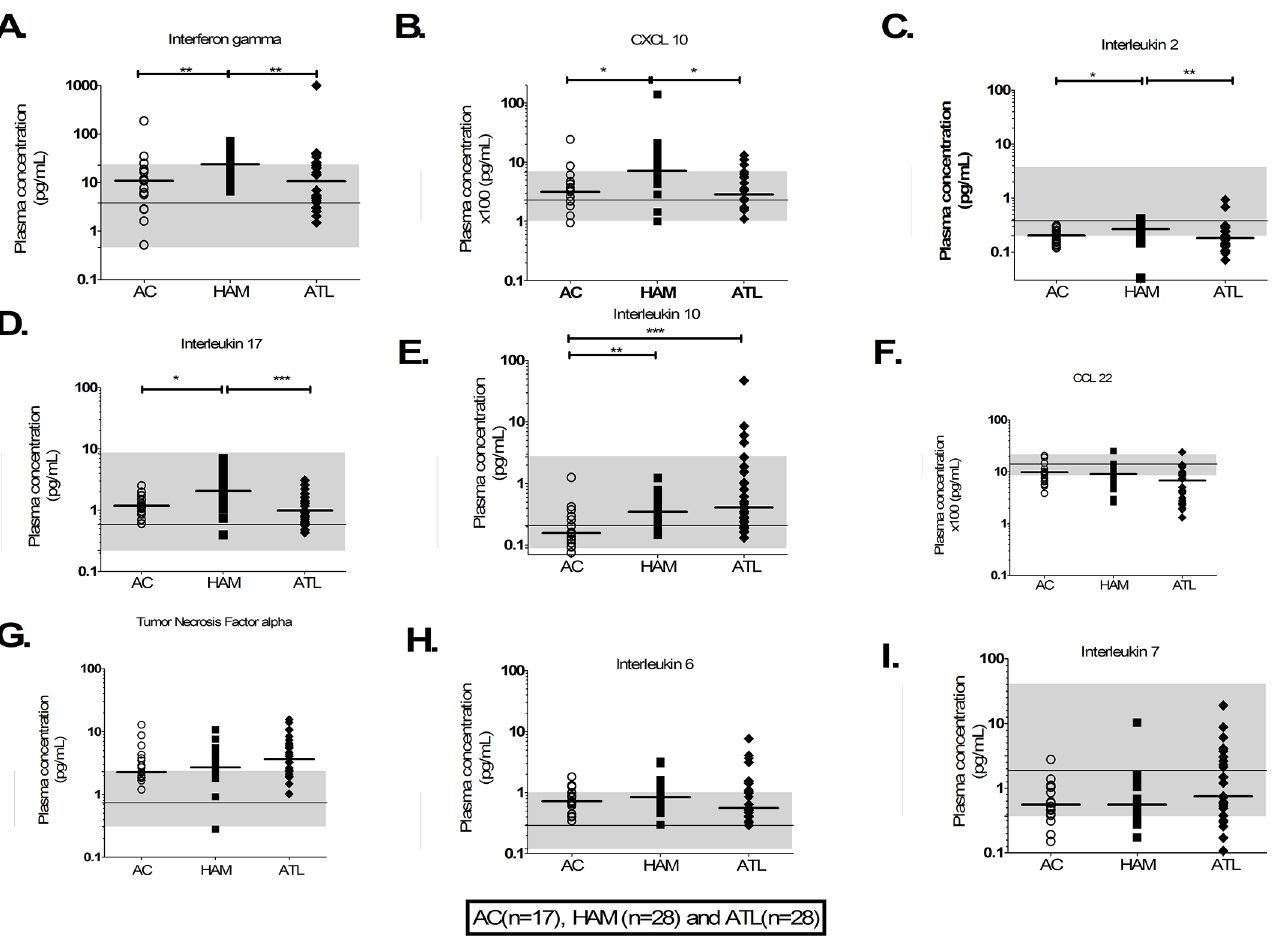
Fig 1. Plasma cytokine concentration in non-ATL HTLV-1 infection and ATL. A-I) Aligned column plots of plasma cytokine/chemokine concentrations in patients with non-ATL HTLV-1 infection and ATL. The bar represents median values. The continuous line and shaded area shows manufacturer supplied median and range in healthy individuals. Statistical analysis: Kruskal-Wallis test with Dunn post-test, 95% confidence interval. (cid:3) denotes p < 0.05, (cid:3)(cid:3) denotes p < 0.01, (cid:3)(cid:3)(cid:3) denotes p < 0.001.